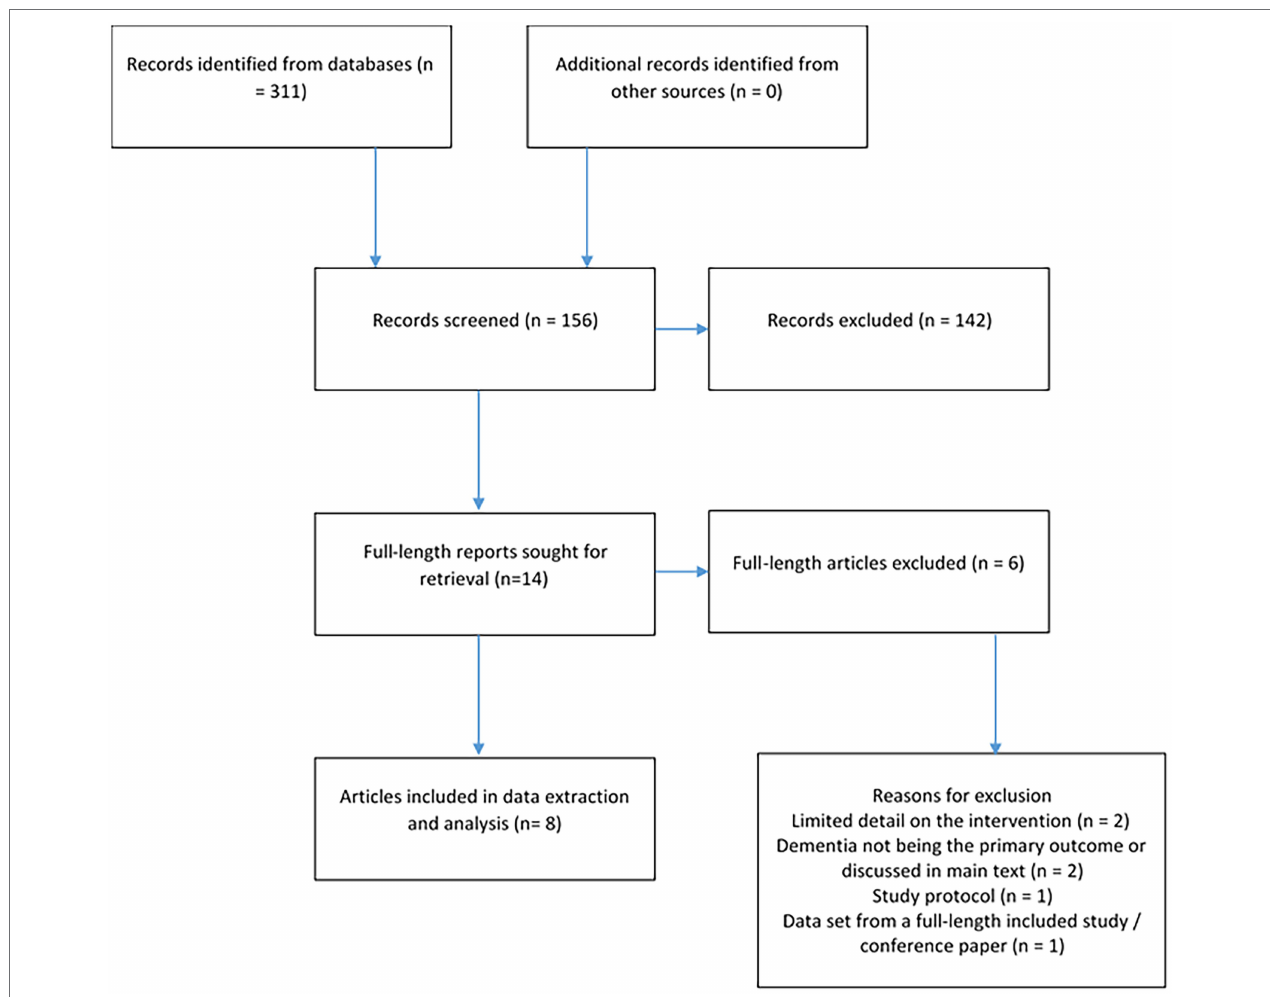
FIGURE 1 | Flow chart of n = 8 included studies with n = 6 excluded full-text articles for having limited detail on the intervention ( n = 2), dementia not being the primary outcome or discussed in main text ( n = 2), for being a study protocol ( n = 1), and the same data set from a full-length included study ( n =